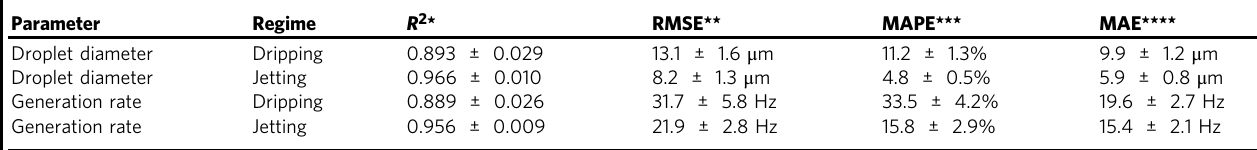
Table 1 Neural networks enable accurate performance prediction in fl ow-focusing droplet generation. The metrics are reported for a 20% test-set (training the models on 80% of the data and leaving 20% for the test-set).